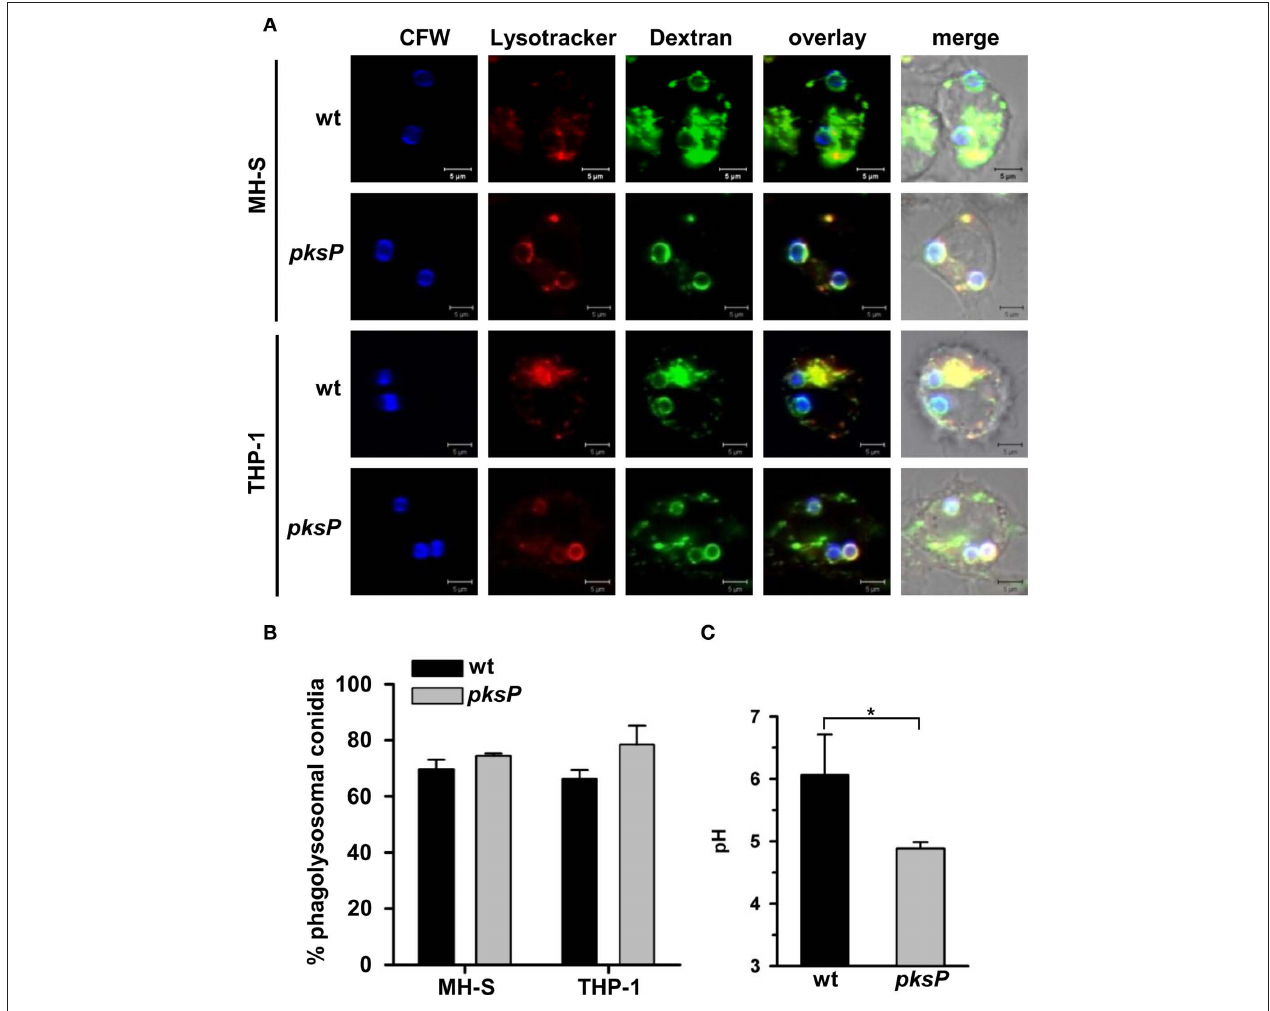
FiguRe 2 | Monitoring of phagolysosomal fusion, acidification of conidia-containing phagosomes, and of intraphagosomal pH. (A) Lysosomes of MH-S and THP-1 cells were chased with Oregon Green (OG) 488-Dextran. Colocalization of calcofluor white (CFW)-stained conidia (blue) with OG488 (green) showing fusion of phagosomes with lysosomes. Acidification of phagolysosomes was studied by LysoTracker (red). Images show representative microscopic pictures. Size bar, 5 μm. (B) Quantification of intracellular conidia